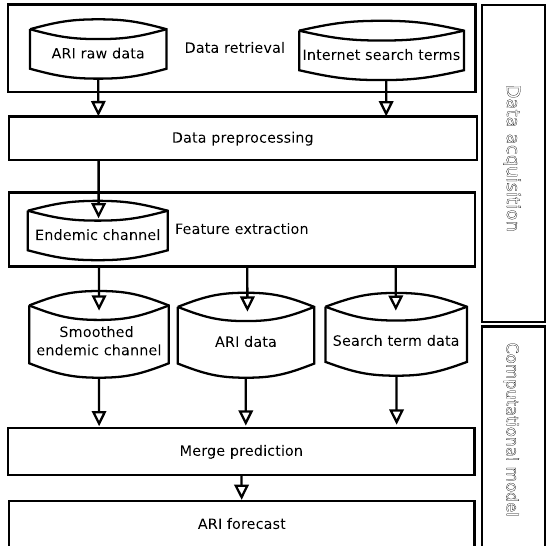
Figure 1. The Proposed Methodology is composed by two stages: the data acquisition and the computational model.